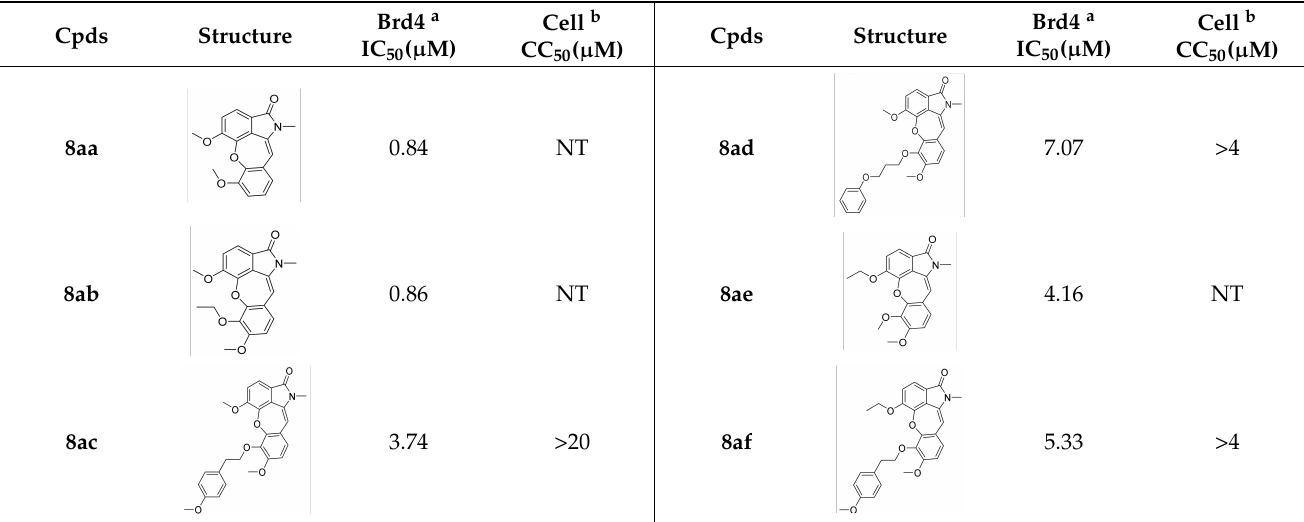
table was calculated with Prism6 program. b To measure the Ty82 cell cytotoxic activity of compounds, MTS assay was performed. The CC 50 in the table was calculated with Prism6 program. NT = not